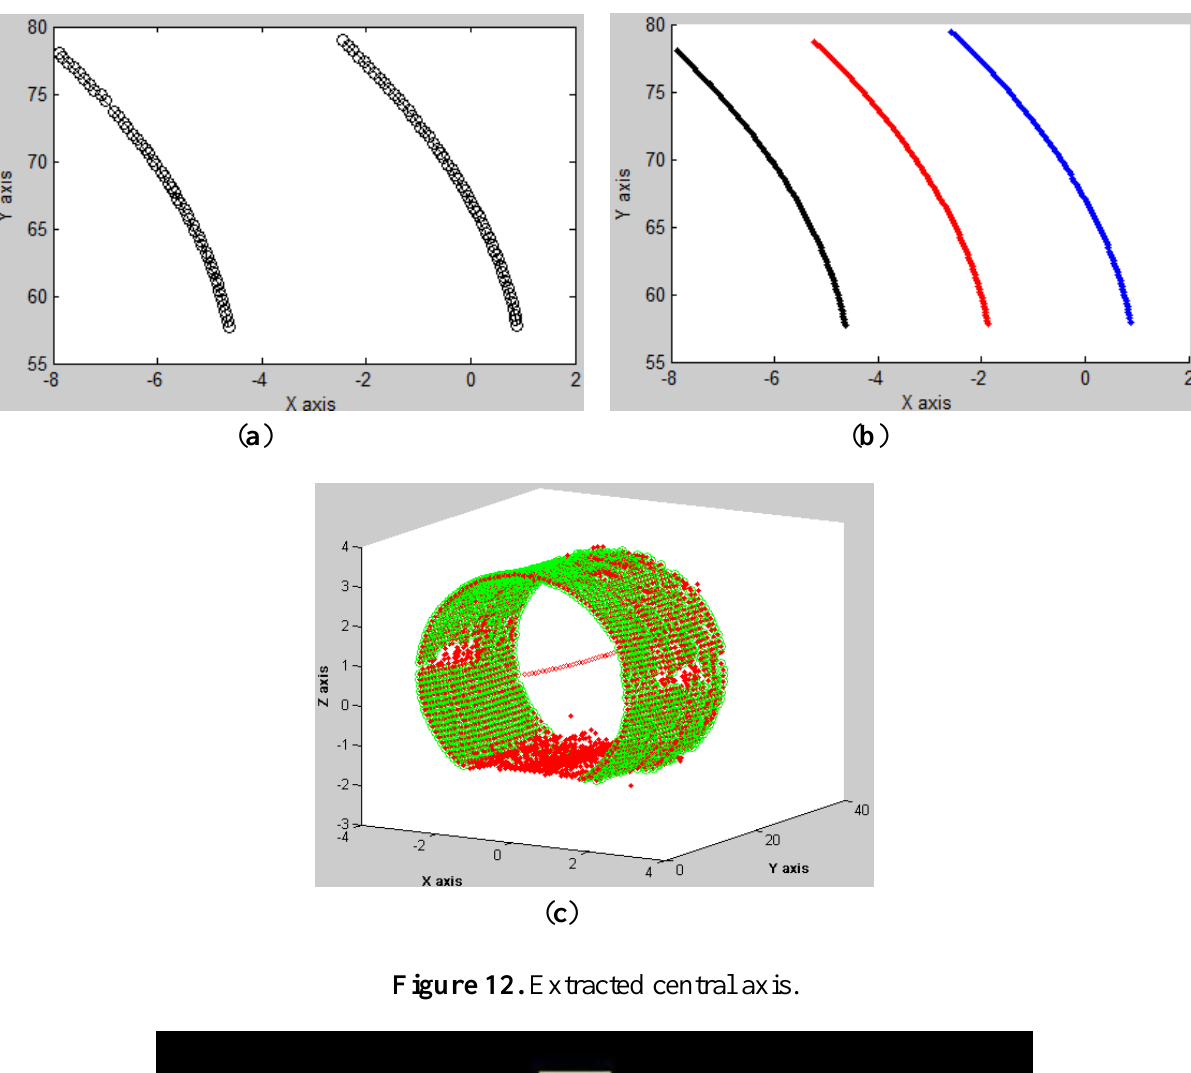
Figure 11. Fitting of the tunnel axis (the transition curve). ( a ) Fitted bounding lines; ( b ) Central-axis extraction; ( c ) Extracted 3D central axis.